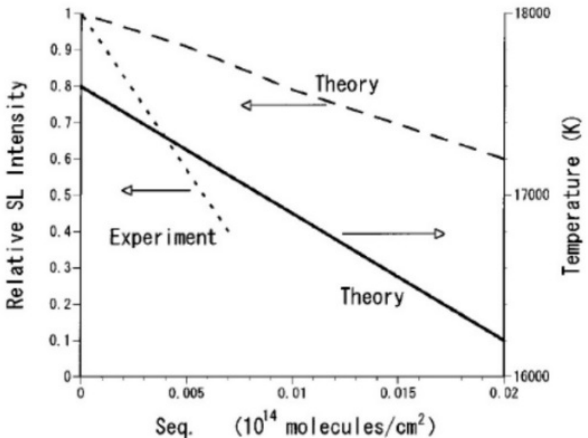
Figure 6. The energy of the emitted light per bubble collapse and the bubble temperature at the collapse as a function of the equilibrium surface concentration of methanol (S eq ) [27]. The experi- mental data of the relative sonoluminescence intensity are also shown [30]. Copyright 2002, with the permission of AIP Publishing.